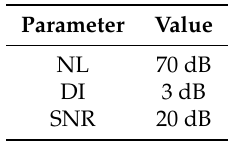
Table 3. Physical layer